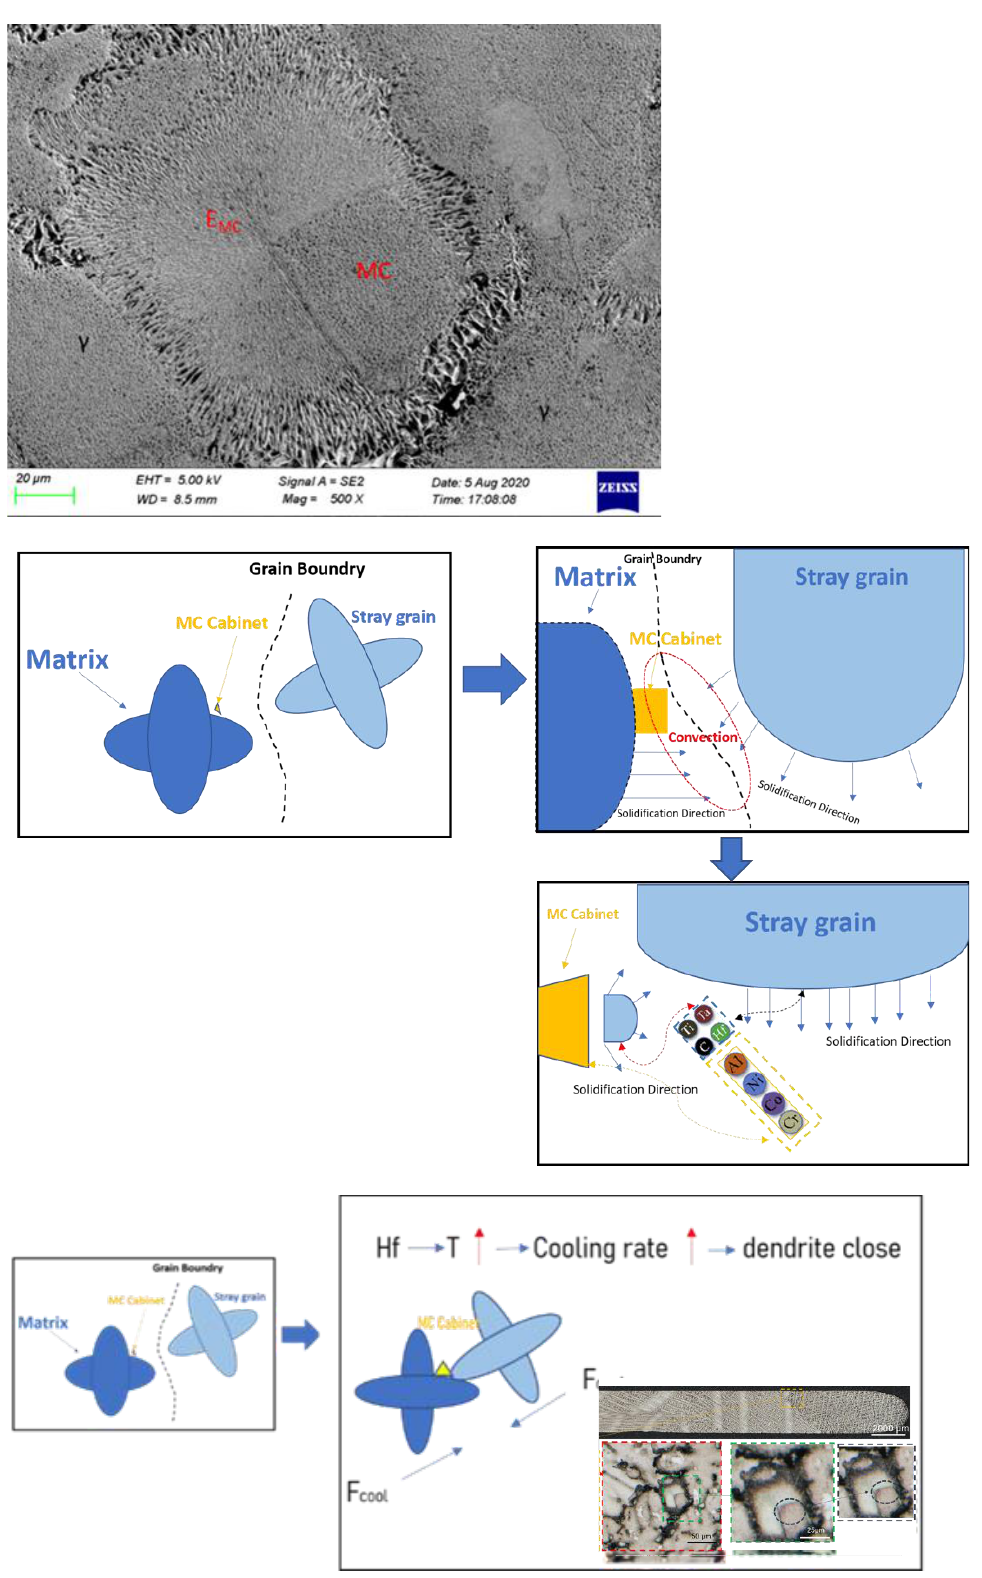
Figure 5. The Hf effect on the growing mode between the MC-type carbide and the eutectic. It is also observed that the Hf concentration of the solidified melt reaches nearly 30%, which can combine with the elements such as nickel and carbon in the molten pool to form compounds and strengthen the bonding strength of dendrites.